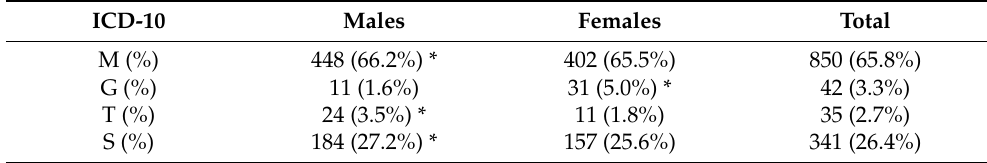
Table 7. The main types of most frequent diagnoses according to gender. * Upper index stars reflect the significance ( p =